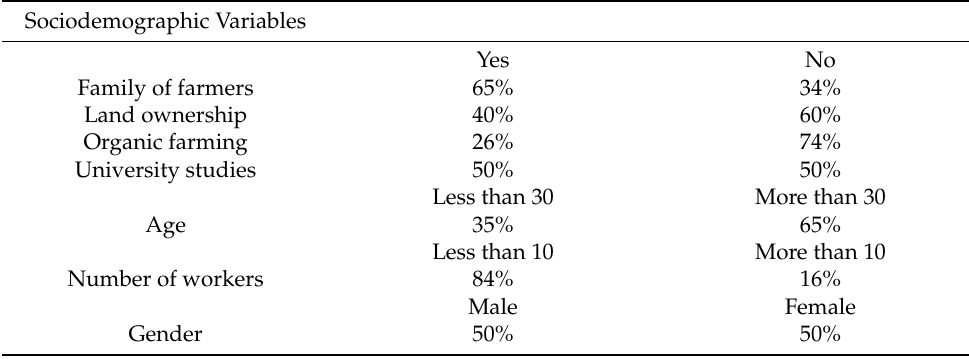
Table 1. Socio-demographic characteristics of farmers in Almer í